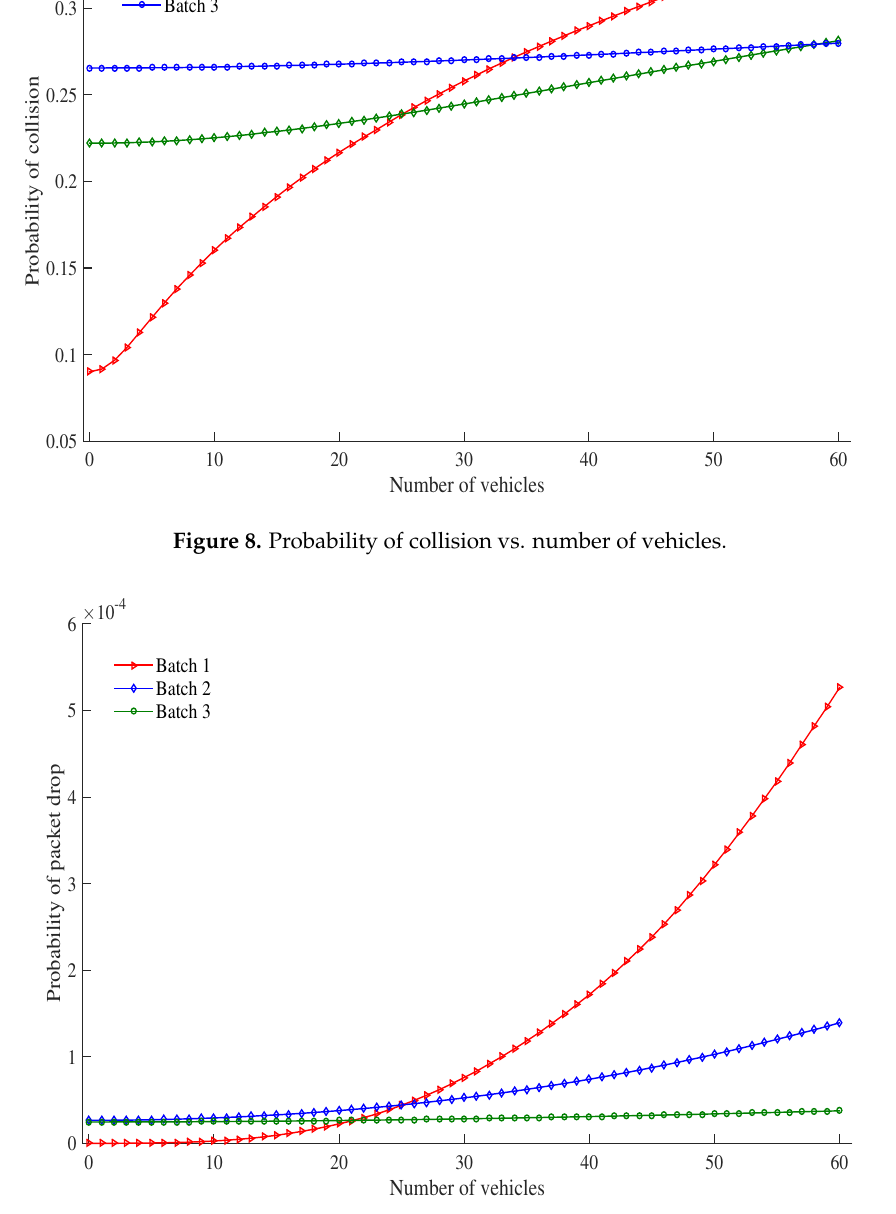
Figure 9. Probability of packet drop vs. number of